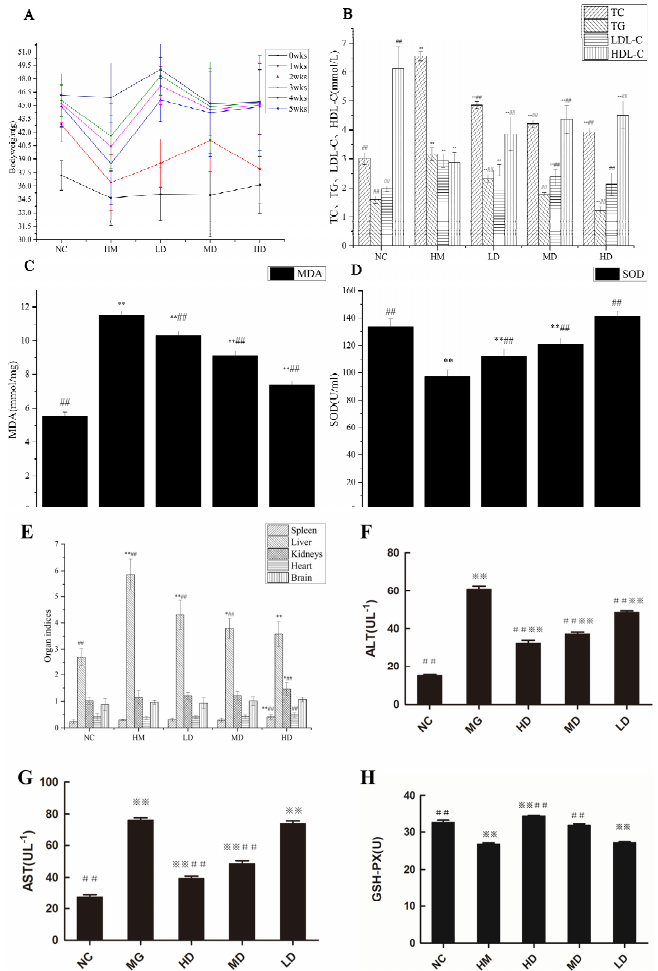
Figure 2. Effect of naringin on hyperlipidemic mice. Values are mean ± SD, n = 8. (A) Body weight. (B) Serum TC, TG, LDL-C, HDL-C levels. (C) Serum MDA levels. (D) Serum SOD levels. (E) Organ indices. (F) Serum ALT levels. (G) Serum AST levels. (H) Serum GSH-Px levels. Note: n = 8; * P < 0.05, ** P < 0.01 compared with those in the blank control. # P < 0.05, ## P < 0.01 compared with those in the model group.